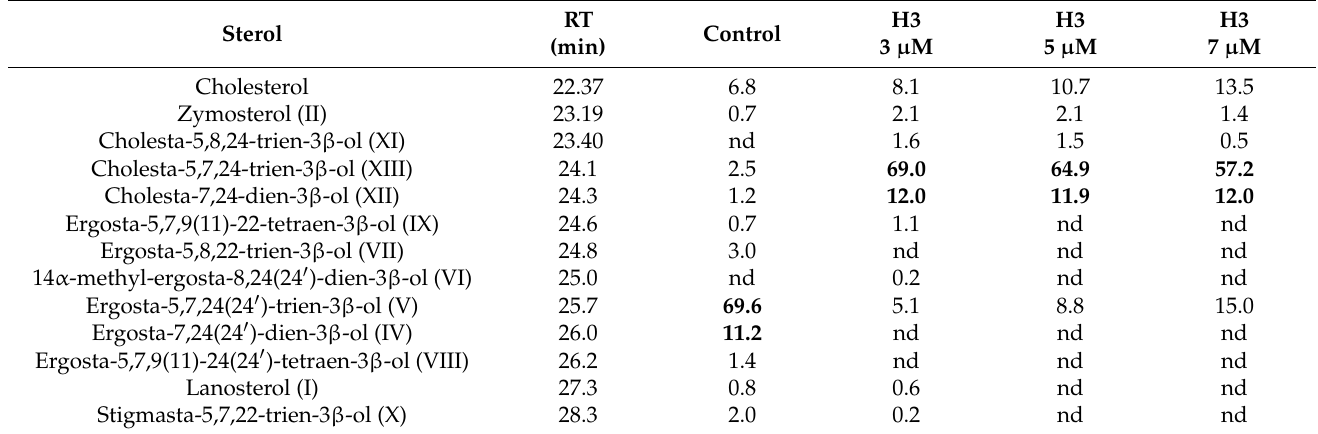
Table 1. Composition of free sterols from H3 -treated and non-treated L. amazonensis promastigotes. Sterol